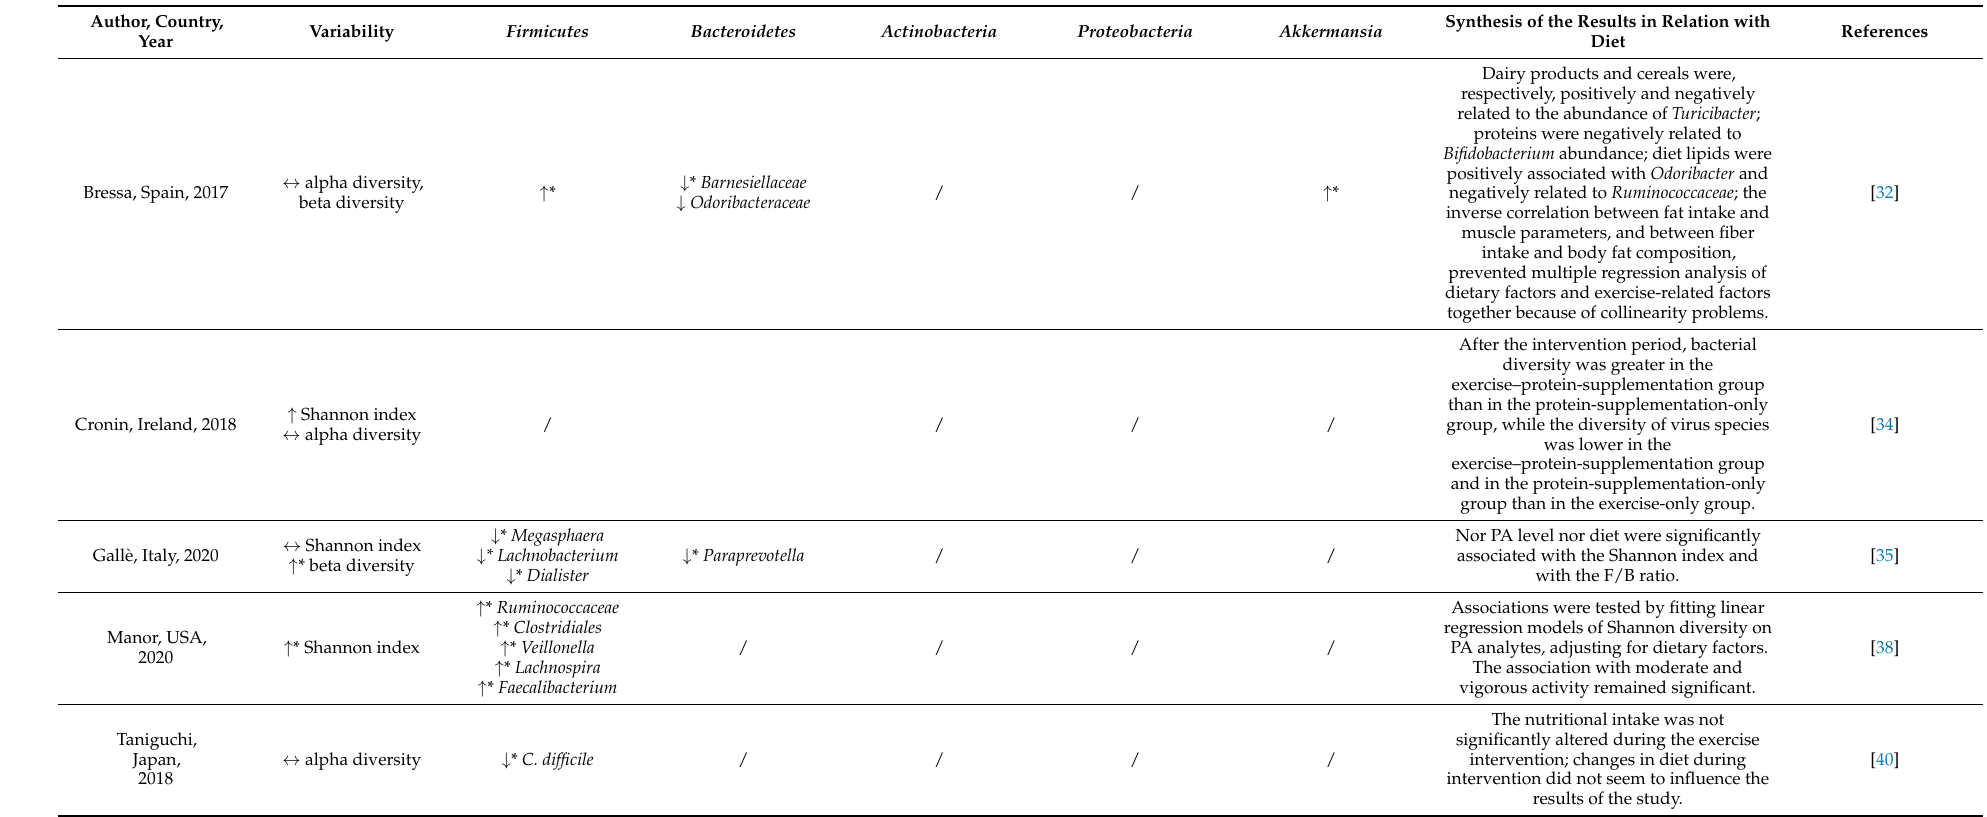
Table 3. Main findings related to gut microbiota variability and composition in active subjects compared to inactive controls from the selected